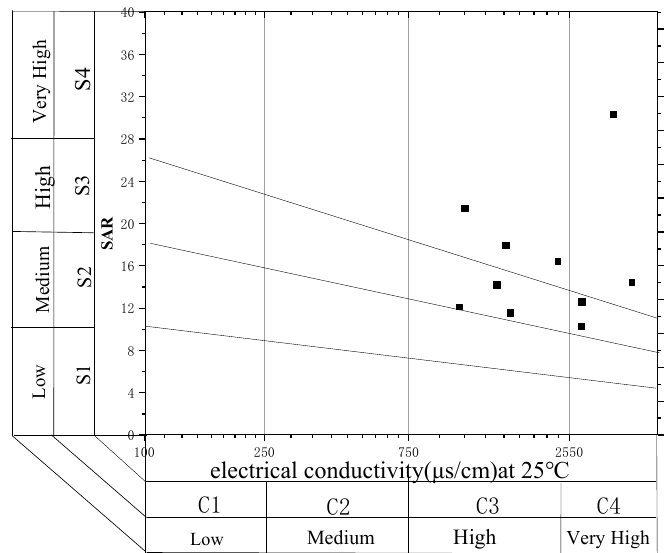
Figure 3. Salinity diagram of CBM produced water. According to the US Salinity Laboratory, salinity is expressed in terms of electrical conductivity and divided into four categories: low in salt (C1), salty (C2), highly saline (C3), and extremely saline (C4). The SAR value of the water is also divided into four categories: low (S1), moderate (S2), high (S3), and extremely high sodium content (S4).